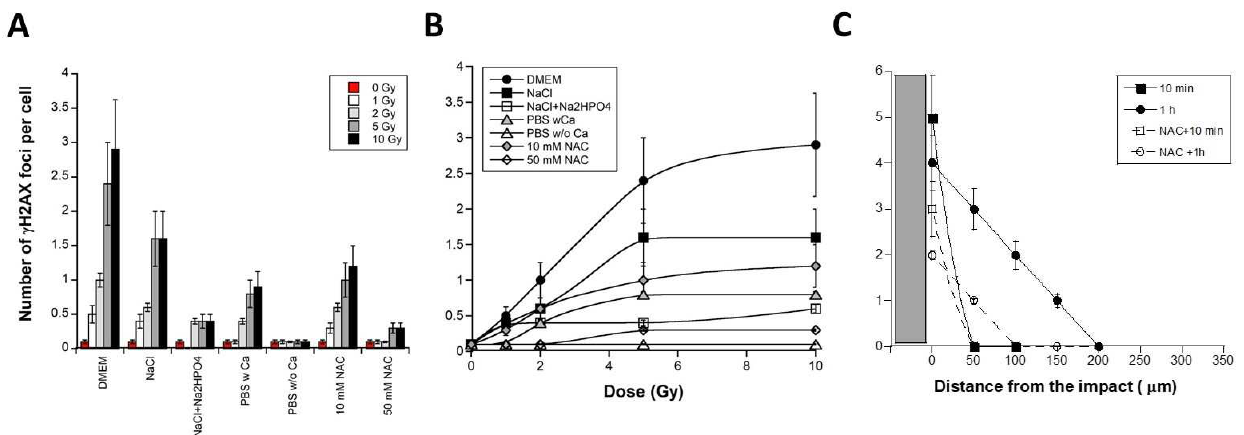
Figure 6. Effect of calcium on the RIBE. One million confluent 1BR3 fibroblasts were irradiated at the indicated doses with monochromatic 50 keV synchrotron X-rays by applying the medium transfer approach (t1 = 10 min and t2 = 4 h) with the indicated medium. Each data plot represents the mean ± SEM of at least three replicates. ( B ). The data shown in panel ( A ) were plotted as function of the initial dose. Each value represents the mean ± SEM of three independent replicates. ( C ). Spatial distribution of γ H2AX foci in RIBE cells after monochromatic 50 keV synchrotron X-rays micro-irradiation. The data represented by closed symbols are those shown in the Figure 3B at 10 min and 1 h post-irradiation. Data represented by open symbols correspond to the γ H2AX data in presence of 50 mM NAC. Each data plot represents the mean ± SEM of at least three replicates. In presence of PBSw/oCa, no γ H2AX foci was observed (data not shown). The grey zone represents a half